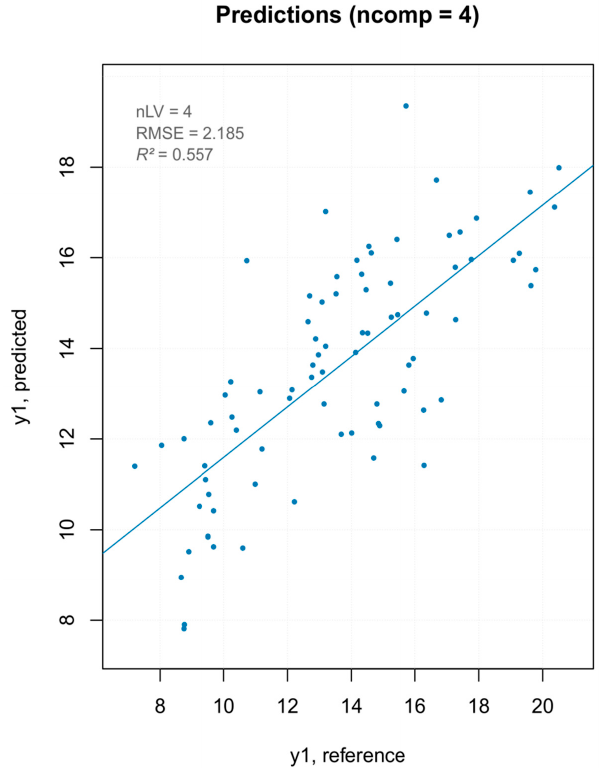
Figure 10. PCA outlier removal—prediction plot for the final model for “hardness” with performance statistics.